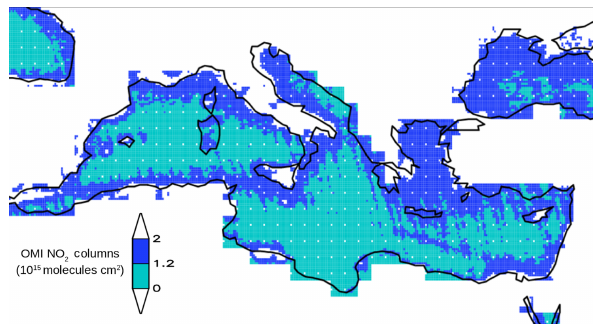
Figure 18. Seasonal average over June–August 2006 of OMI NO 2 columns over the Mediterranean Sea (10 15 moleculescm − 2 ), re- trieved from the OMI satellite and considering only maritime pixels (reproduced from Marmer et al.,